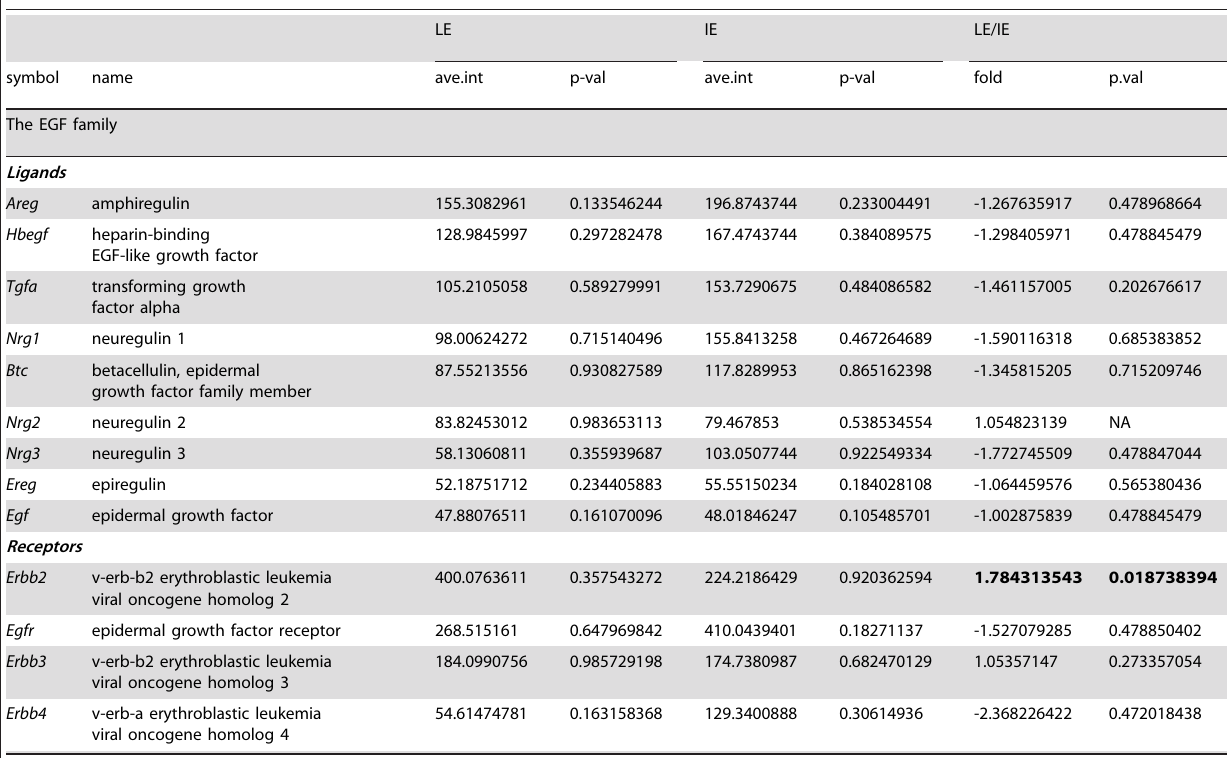
Table 3. Expression of Genes in the EGF pathways